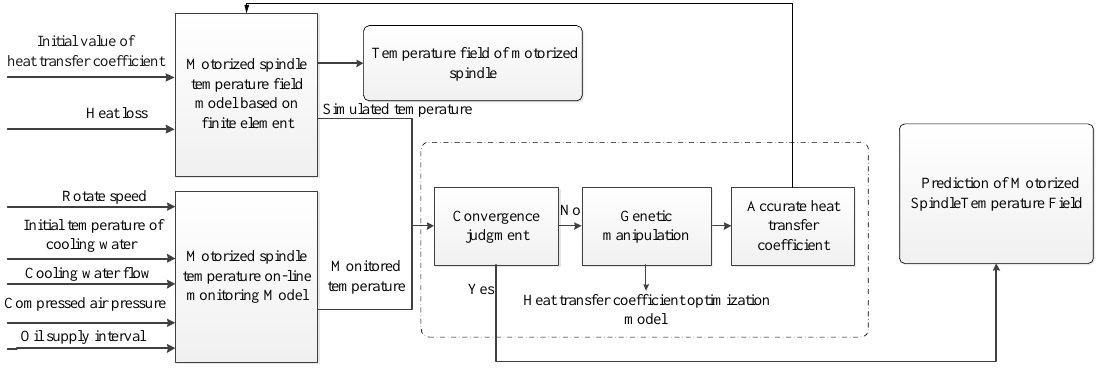
Figure 2. Prediction model of the temperature field of the motorized spindle.